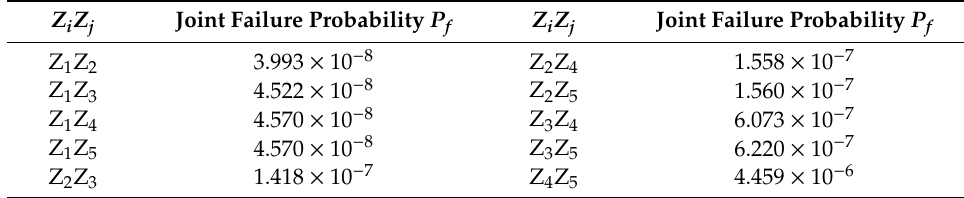
The best-fitting copula function was selected based on the principle of minimum AIC and BIC